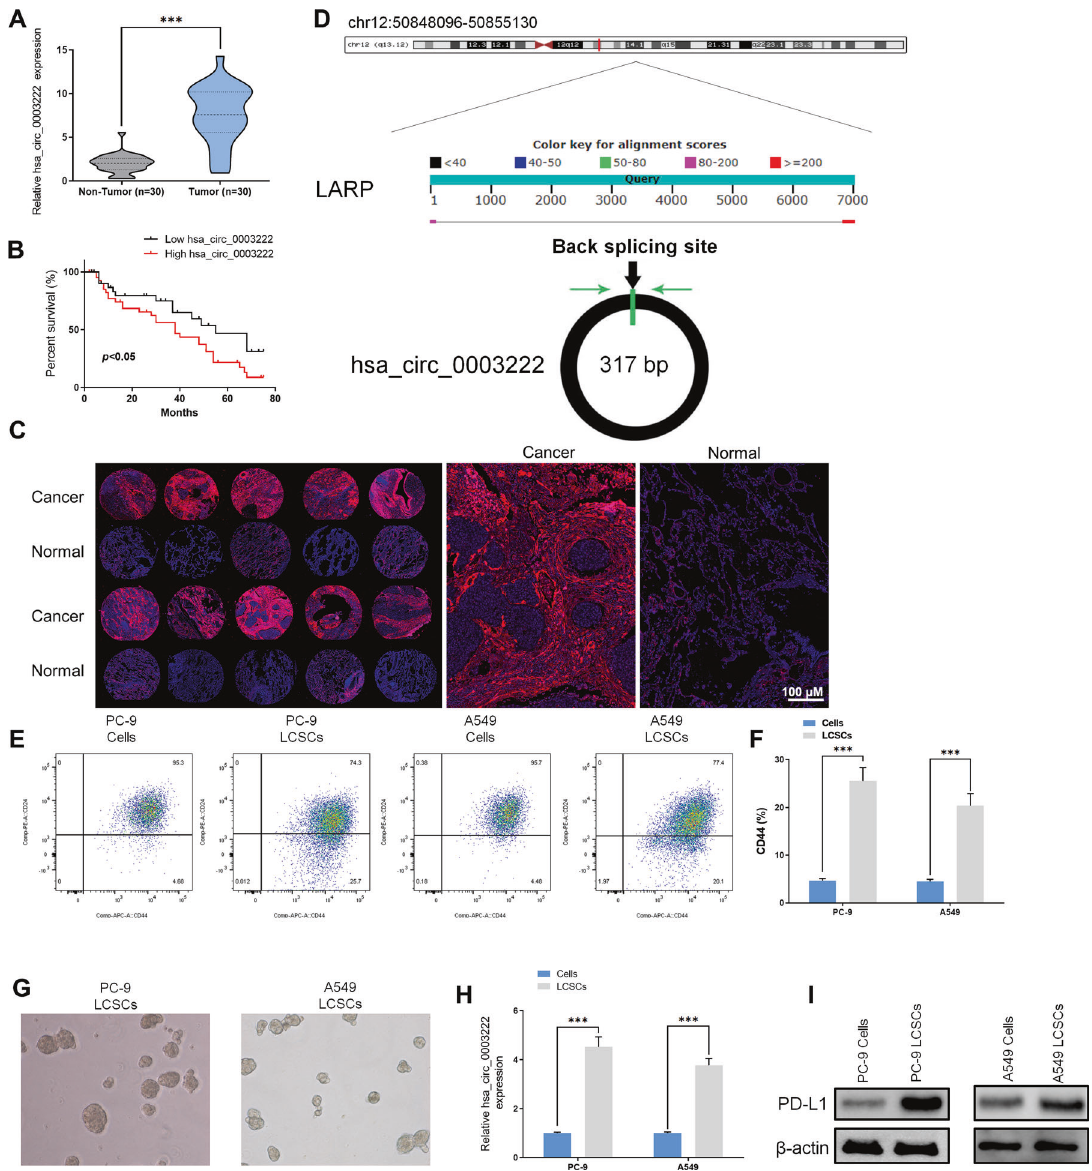
Fig. 1 hsa_circ_0003222 predicted a negative prognosis in NSCLC patients. A hsa_circ_0003222 level from 30 NSCLC tumor tissues and adjacent non-tumor tissues. B Overall survival of NSCLC in relation to hsa_circ_0003222 level. C The expression of hsa_circ_0003222 in NSCLC was examined by in situ hybridization on an NSCLC tissue microarray analysis (TMA) (74 cases). D LARP4 gene and hsa_circ_0003222 genomic loci. E , F Flow cytometry determination of the proportion of PC9 and A549 lung cancer stem cells (LCSCs) expressing CD44. G Spheroid formation was assessed in PC9 and A549 LCSCs. H RT-qPCR demonstrating hsa_circ_0003222 level in PC9 and A549 or LCSCs. I Western blot demonstrating PD-L1 level in PC9 and A549 cells or LCSCs. Data were shown as mean ± SD; *** P <